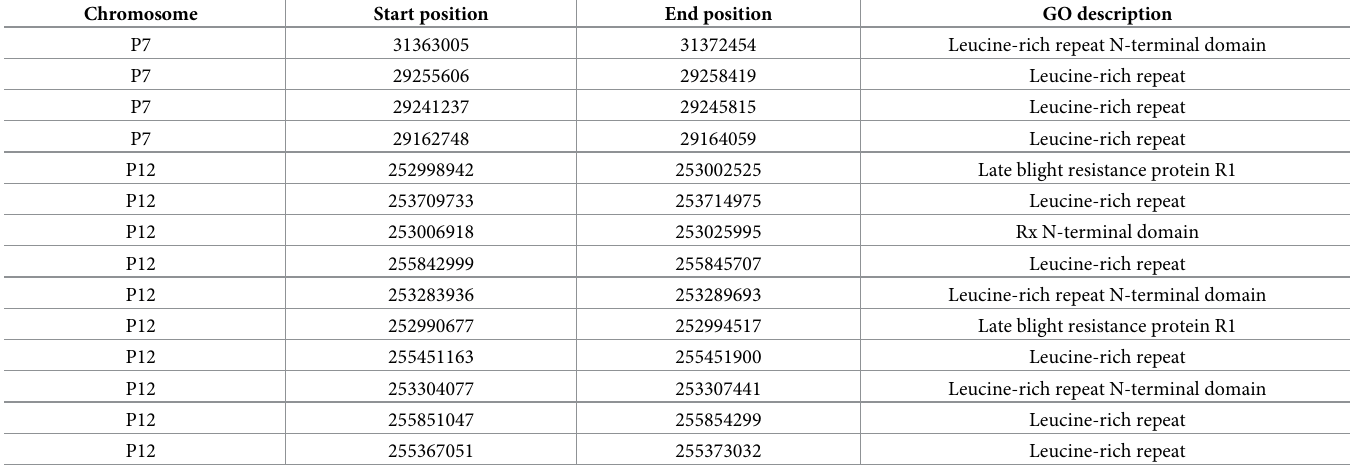
Table 4. Candidate genes associated with PepYLCV resistance and their functions.